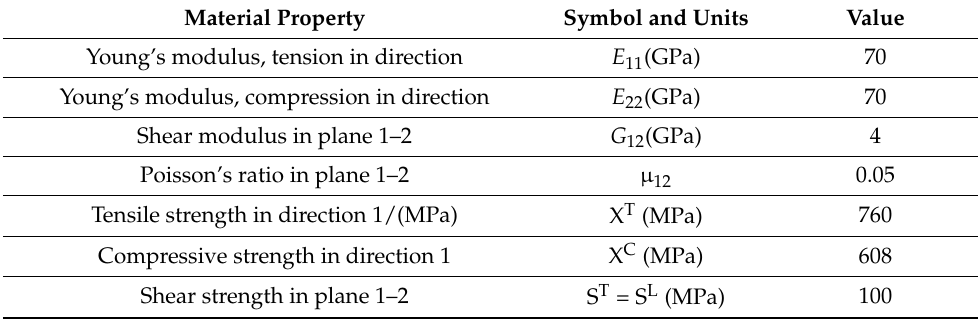
Table 1. Mechanical properties of